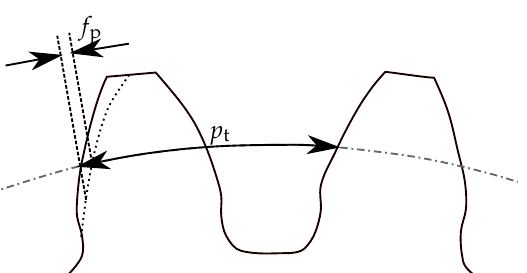
Figure 3. Circular pitch p t and single pitch deviation f p of a gear according to